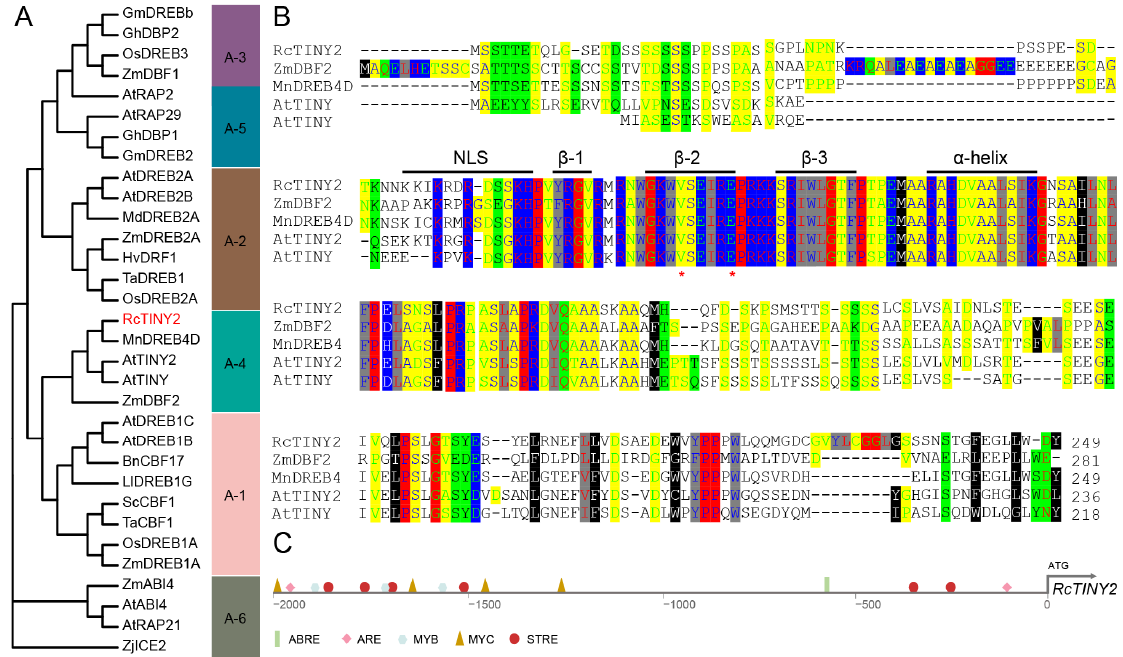
Figure 1. Sequence and phylogenetic relationship analysis of RcTINY2. ( A ) Analysis of phylogenetic relationships between RcTINY2 and other plant DREB proteins. CLUSTALW, with default parameters, was used to make alignments. MEGA 7.0 software was used to perform neighbor-joining using 1000 replicates. Accession numbers used were as follows: RcTINY2, MH152410; LlDREB1G,